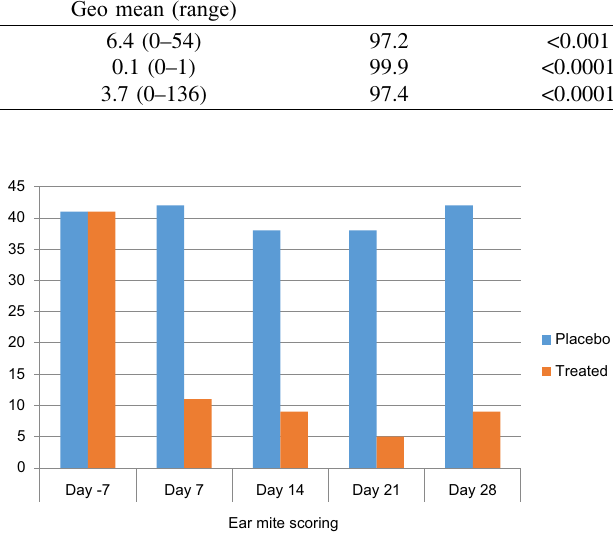
Figure 1. Ear mite otoscopical scoring in Lab #1. Sum of individual otoscopical scores of live mites inclusive of both ears of each cat per group ( n = 8).